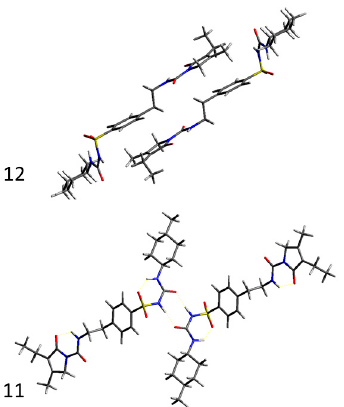
Figure 6. Illustration of the two strongest interacting dimers (11 and 12) in the crystal lattice of glimepiride.